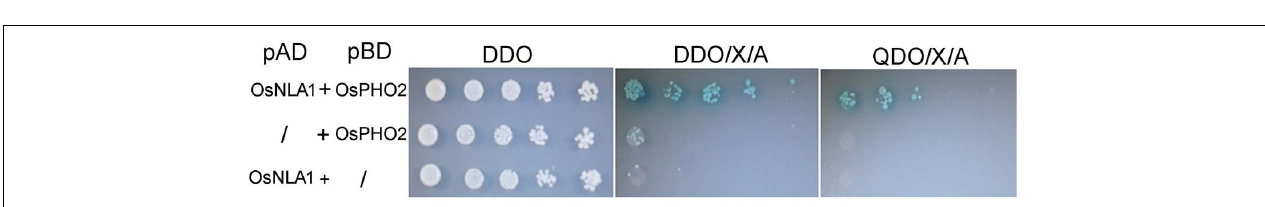
FIGURE 8 | Analysis of interaction between OsNLA1 and OsPHO2 using yeast-two hybrid (Y2H) assay. Yeast hybrid cells carrying combination of pGAD7-AD and pGBKT7-BD constructs were spotted on DDO (selection for both plasmids), DDO/X/A (for relaxed selection) and QDO/X/A (for stringent selection). Yeast hybrid cells only carrying pGADT-OsNLA1 and PGBKT7-OsPHO2 combination were able to grown on DDO/X/A and QDO/X/A plates. {pAD - pGADT7-AD; pDB – pGBTK7-DB; DDO - SD/-Leu/-Trp/(double dropout); DDO/X/A (SD/-Leu/-Trp/X-a-gal/Aureobasidin A); QDO/X/A (SD/-Leu/-Trp/-His/-Ade/X-a-gal/Aureobasidin A)}.